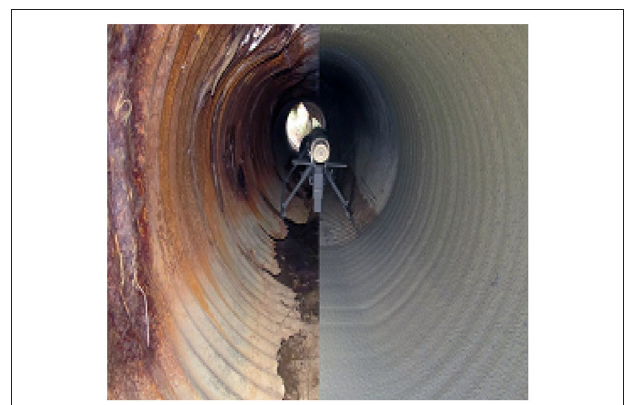
FIGURE 1 | Displaying SAPL & CIPP pipe renewal methods. https://www. trenchless-pipelining.com/miami-epoxy-pipe-lining-company/.